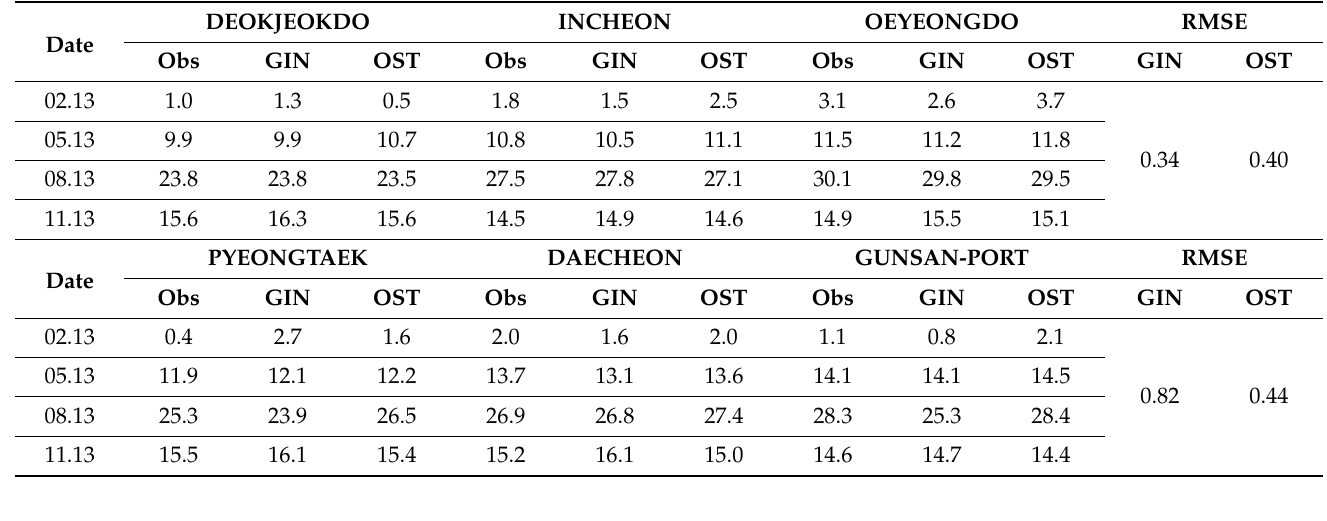
Table 2. Comparison of the GIN and OSTIA with buoy observations.